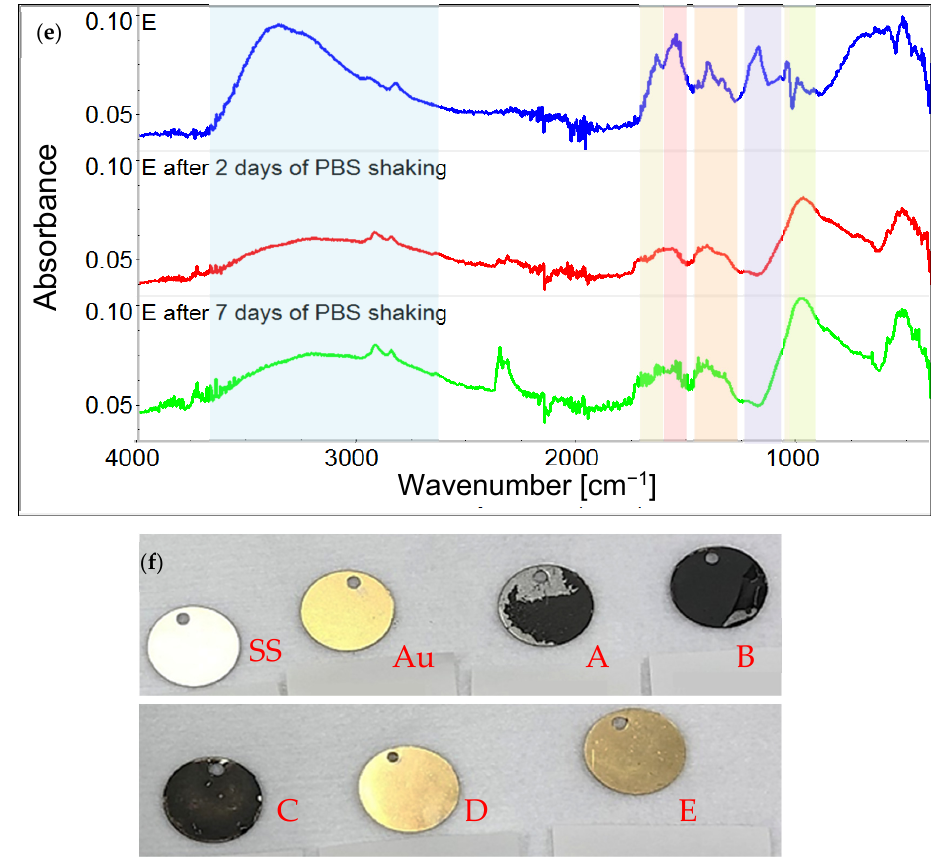
Figure 2. FITR spectra for metals coated with GO immediately after preparation, after 2 days, and after 7 days of PBS shaking. ( a ) Variant A, ( b ) variant B, ( c ) variant C, ( d ) variant D, and ( e ) variant E. ( f ) Pictures of all sample variants after 48 h of washing. Visible losses in coatings after washing, especially in variant A.